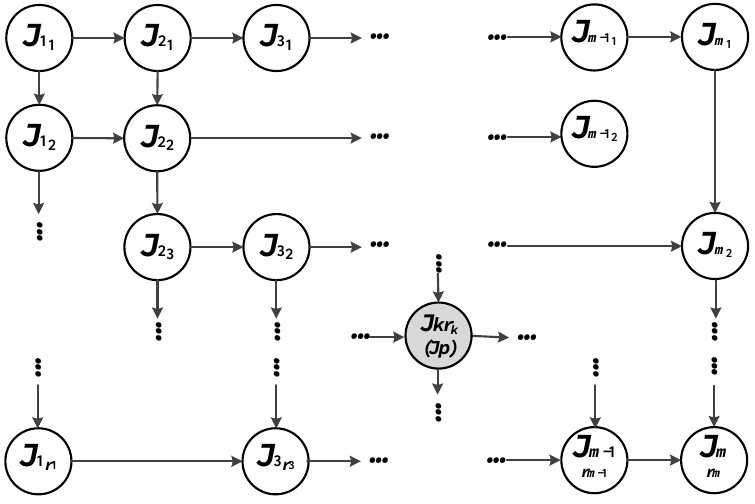
Figure 1. An example of the directed graph of a mixed-flow shop.